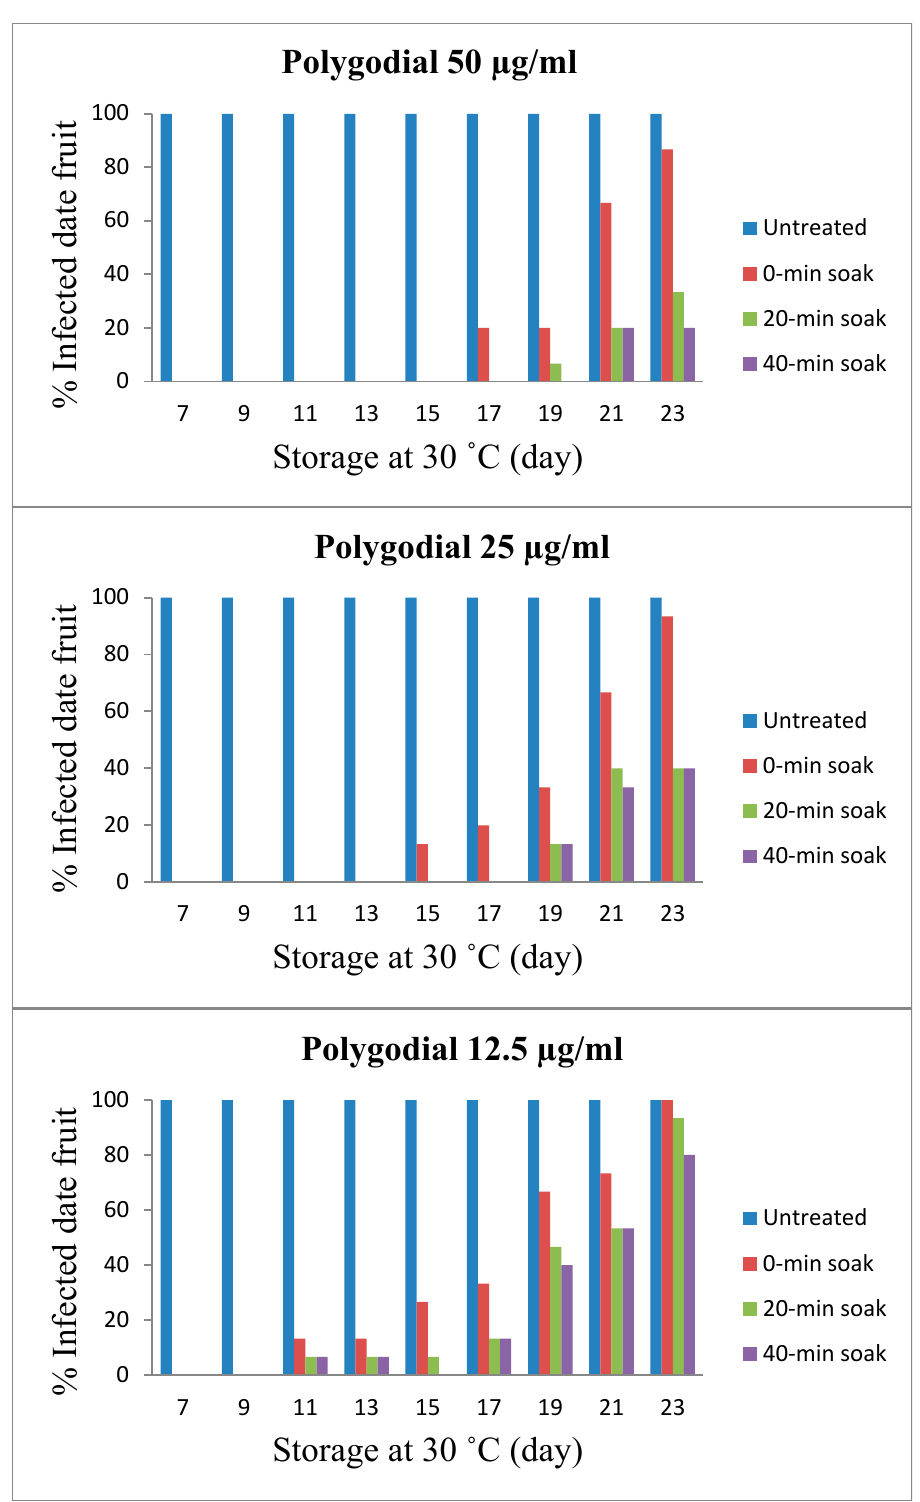
Figure 3. Effects of polygodial concentrations (12.5, 25, and 50 µg/mL) found in TPL extract extend the shelf life of fresh dates ( Barhi cultivar) stored at 30 °C. Untreated dates lasted for 7 days before being infected by fungi. Increases in polygodial concentration and soaking period revealed increased shelf life of fresh